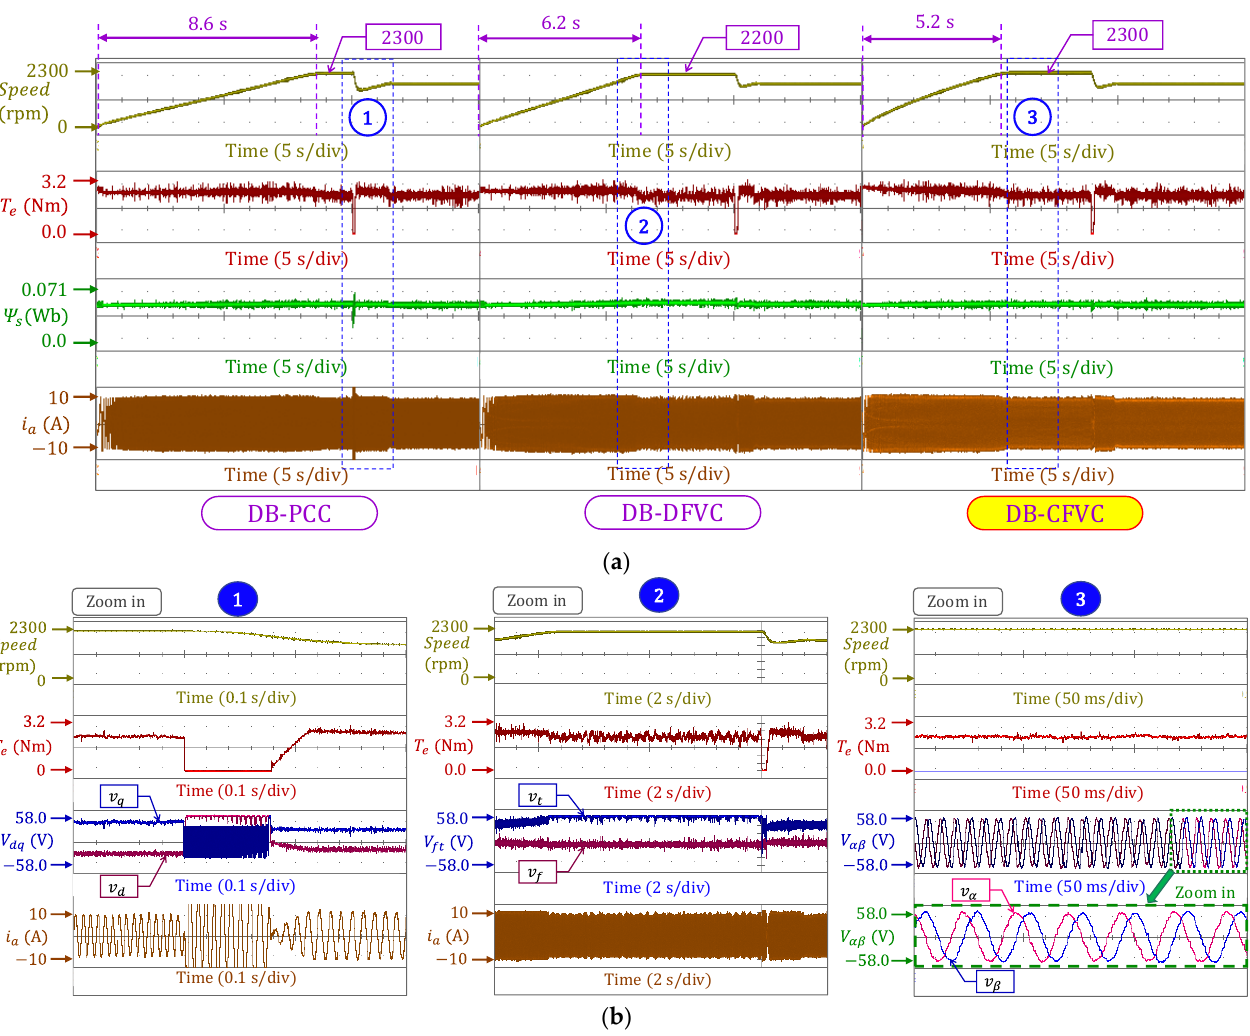
Figure 6. Experiment results of dynamic performance comparison between DB-PCC, DB-DFVC, and proposed DB-CFVC: ( a ) comparison of response time as sped up to 2300 rpm at load torque 2.5 Nm; ( b ) zoom-in at the points ( 1 – 3 ) in ( a ) to analyze voltage command waveforms.